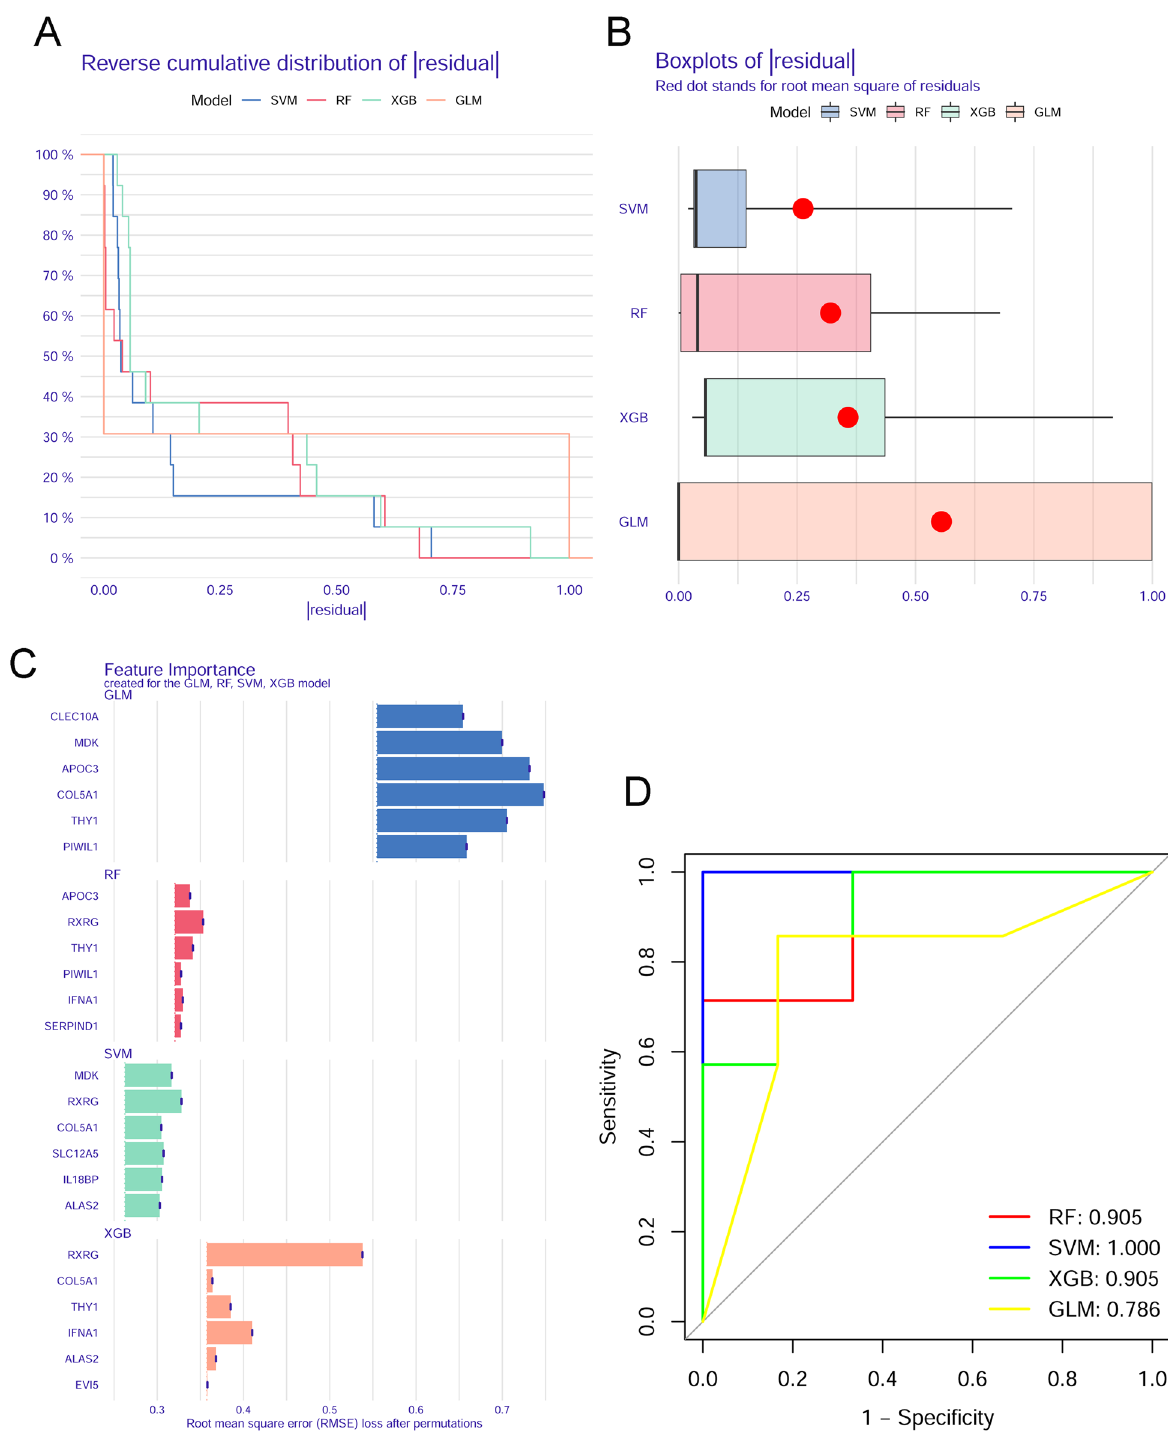
Figure 8. Construction and assessment of RF, SVM, GLM, and XGB machine learning models. ( A ) The reverse cumulative residual distribution of each machine learning model. ( B ) The residuals of each machine learning model were presented in boxplots. The root mean square of residuals is shown as a red dot. ( C ) The important features in four machine models. ( D ) ROC analysis of four machine models based on fivefold cross-validation in the testing